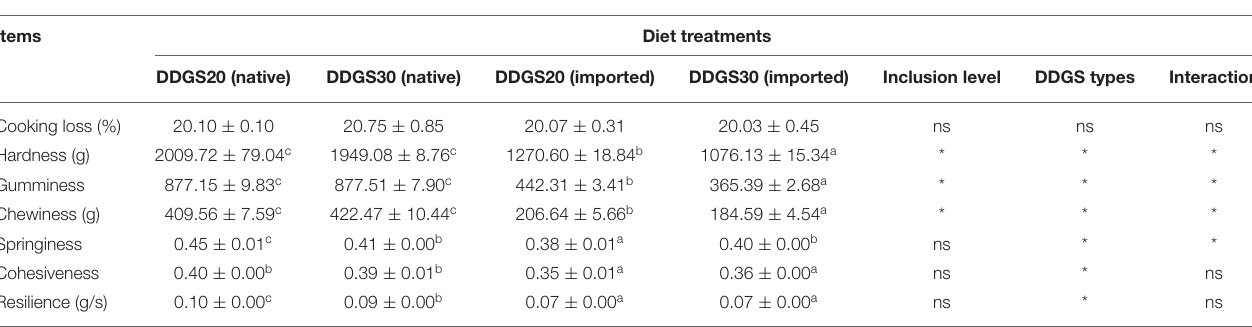
TABLE 8 | The effects of different types and levels of dietary DDGS on cooked muscle texture a .